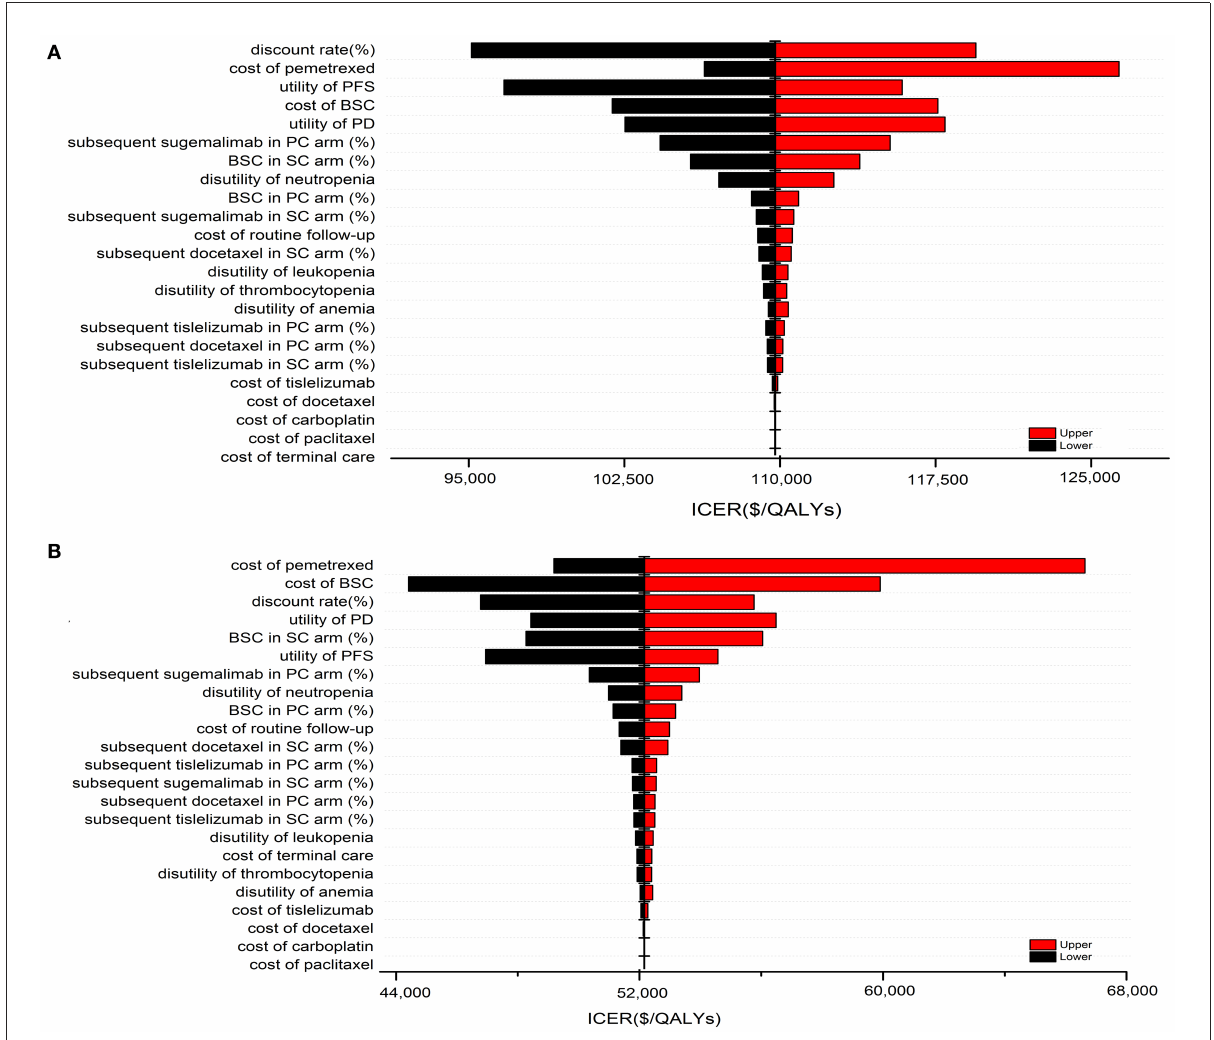
FIGURE3 One-way sensitivity analysis of SC in comparison with PC for the ITT population without PAP (A) and with PAP (B) .